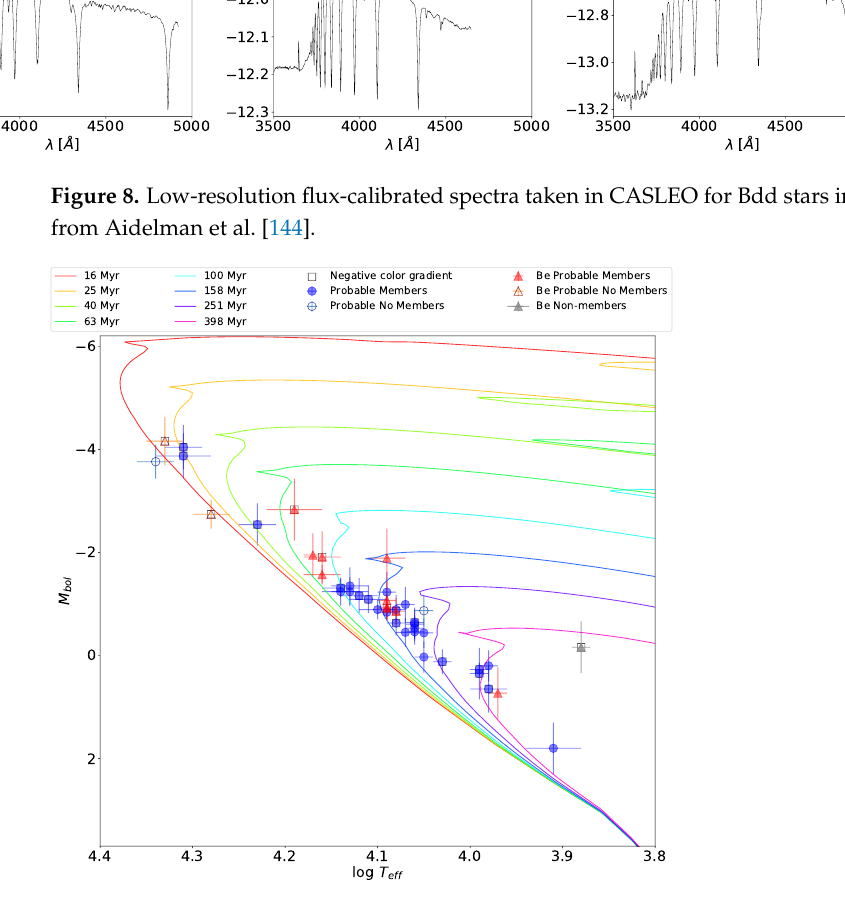
Figure 9. HR diagram of B and Be stars (members or probably not members) in NGC 3114 whose parameters were determined using the BCD system. The isochrones are from Ekström et al. [145]. Adapted from Aidelman et al.